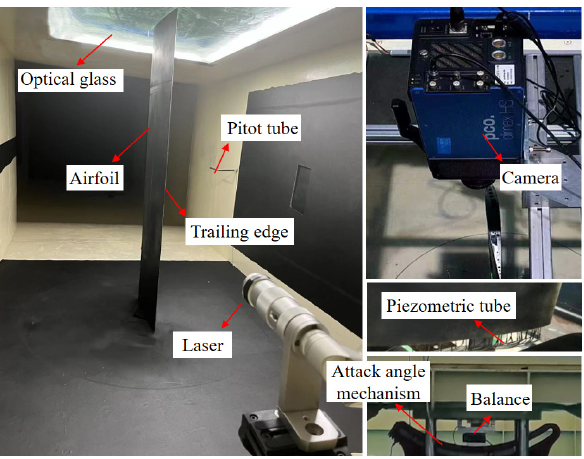
Figure 1. Experimental physical layout.